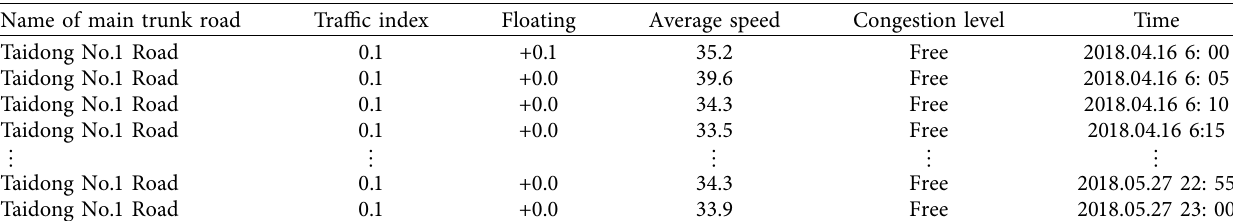
Figure 1: The flow chart. Table 1: TPI data